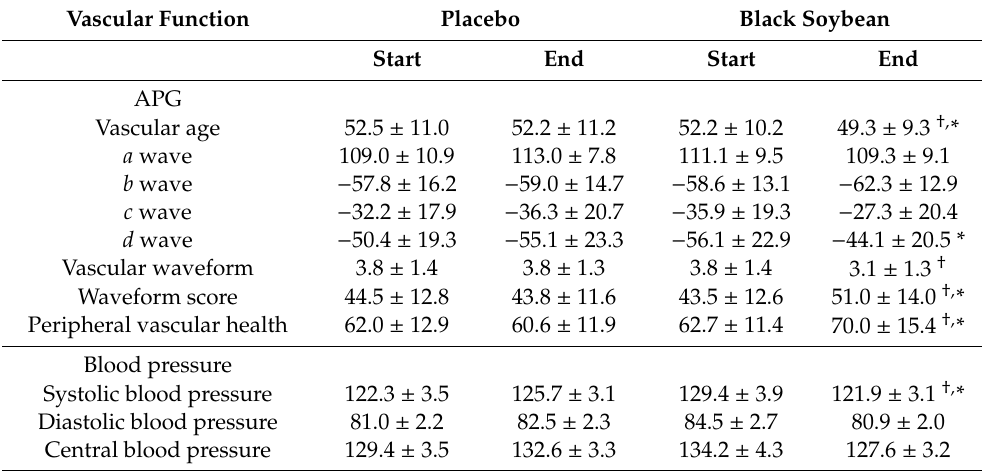
Table 4. The e ff ects of black soybean consumption on the vascular function. Vascular Function